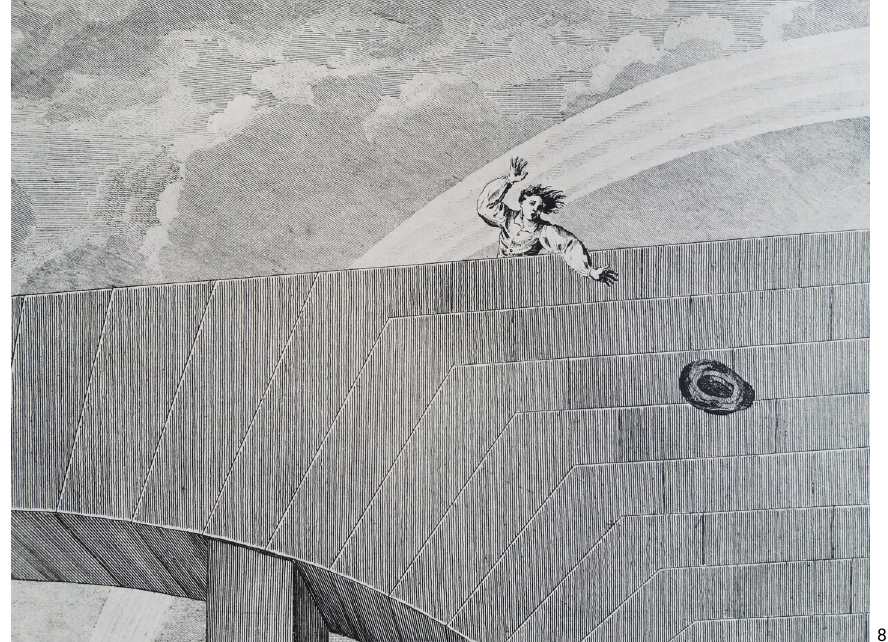
Claude-Nicolas Ledoux, “abreu- voir et lavoir de Meilliand,” detail. From Claude-Nicolas Le- doux, L’architecture considérée sous le rapport de l’art ,